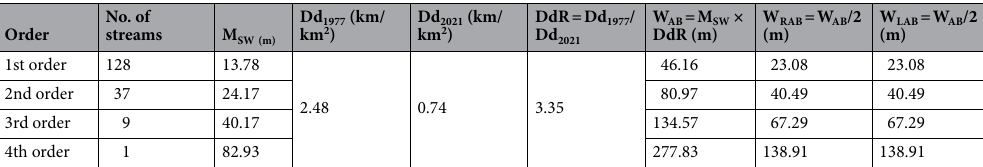
Table 3. Summary of AB